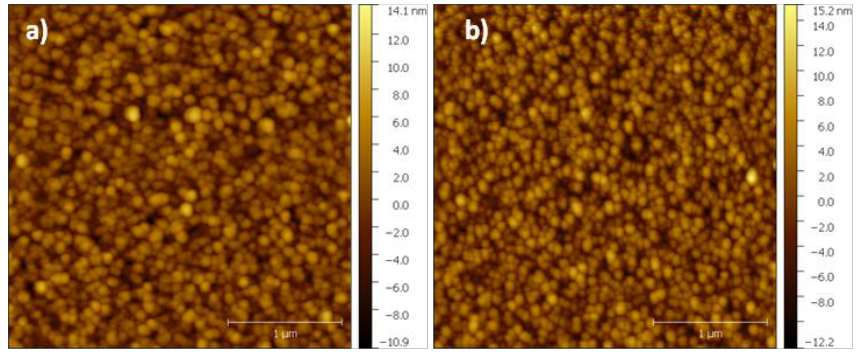
Figure 6. Atomic force microscopy images of SiC ( a ) and AlN ( b ) films.